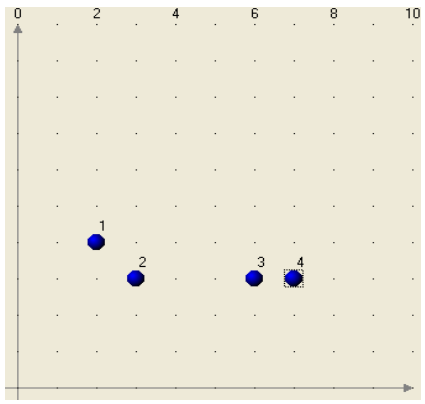
Figure 1. Dataset for clustering.